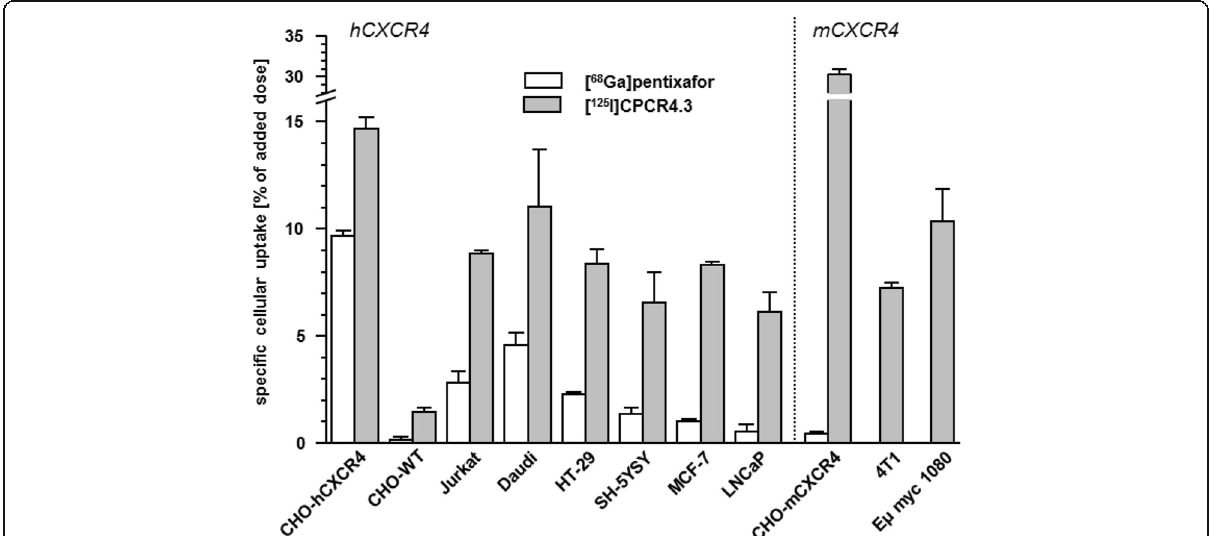
Fig. 2 CXCR4-specific cellular uptake of [ 125 I]CPCR4.3 (0.1 nM) and [ 68 Ga] Pentixafor (1 nM) in different hCXCR4- and mCXCR4 expressing cell lines (60 min, 37 °C). CHO-WT (non-transfected CHO cells) were included as negative control. Data are corrected for non-specific binding in the presence of 100 μ M AMD3100. Experiments were performed in triplicate, and data are means± SD